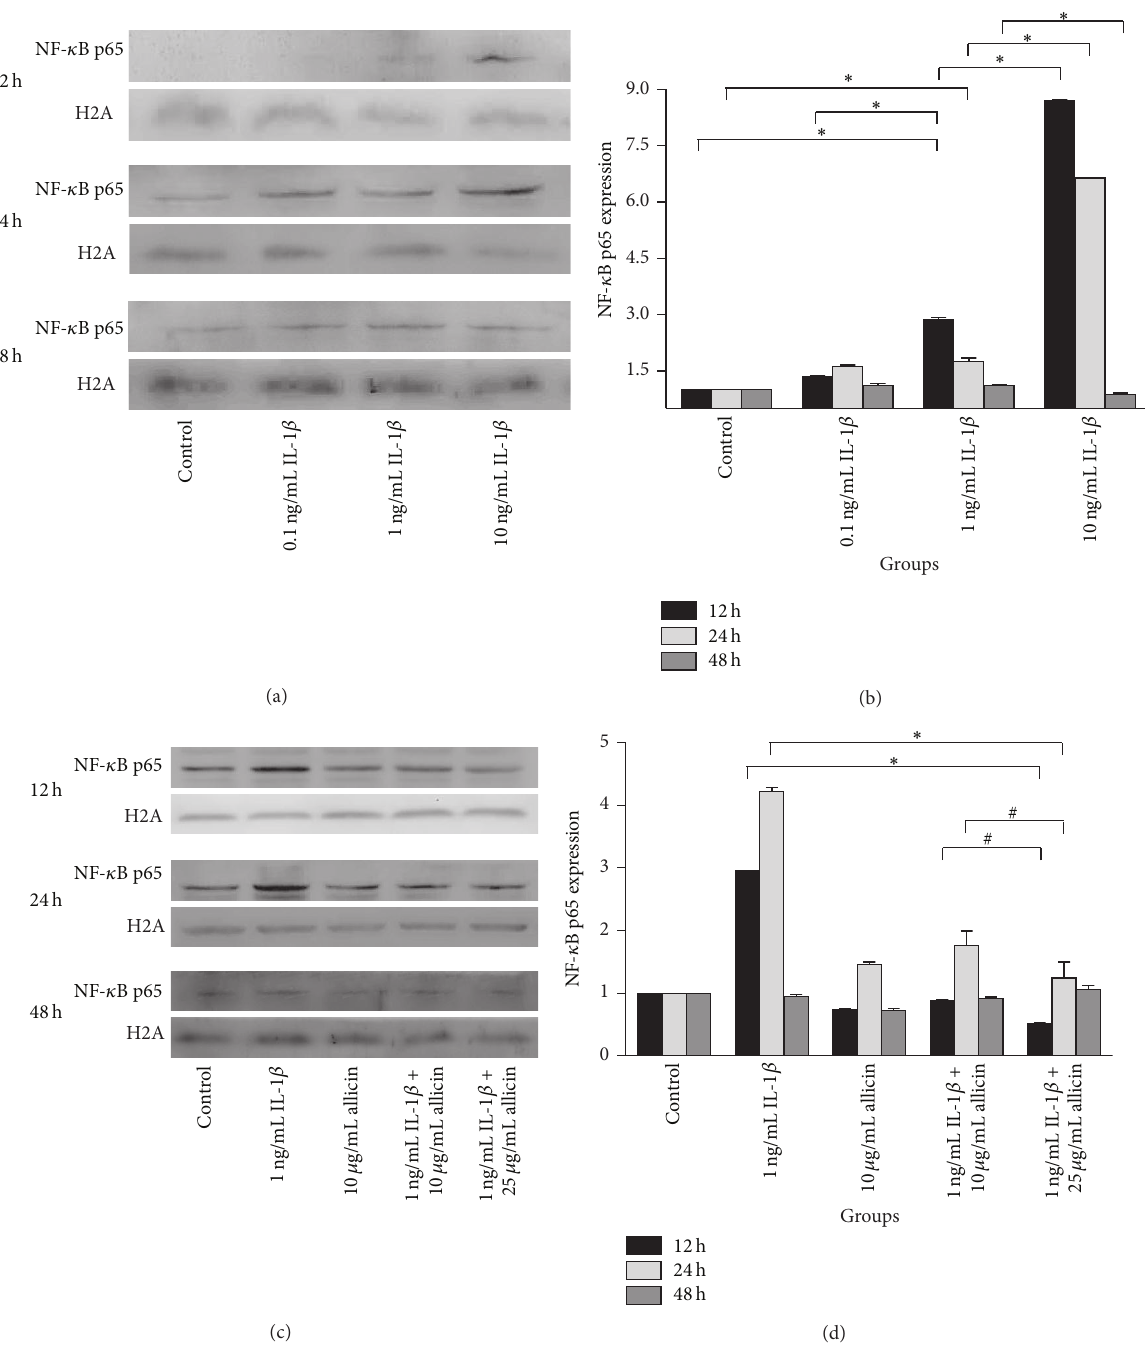
Figure 6: NF- 𝜅 B p65 was increased in IL-1 𝛽 -induced Caco-2 cells (a and b): IL-1 𝛽 induced the expression of NF- 𝜅 B p65 in nucleus of Caco-2 cells at 12 and 24 h. ∗ 𝑃 < 0.05 versus 1ng/mL IL-1 𝛽 group. Allicin influenced inflammation caused by IL-1 𝛽 in Caco-2 cells (c and d): 25 ng/mL allicin decreased the expression of NF- 𝜅 B p65 in nucleus of IL-1 𝛽 -induced Caco-2 cells at 12 and 24 h. ∗ 𝑃 < 0.05 1ng/mL IL-1 𝛽 group versus 1ng/mL IL-1 𝛽 + 25 𝜇 g/mL allicin group. # 𝑃 < 0.05 1ng/mL 1ng/mL IL-1 𝛽 + 10 𝜇 g/mL allicin group versus 1ng/mL IL-1 𝛽 + 25 𝜇 g/mL allicin group. Data were presented as mean ± SD and repeated 3